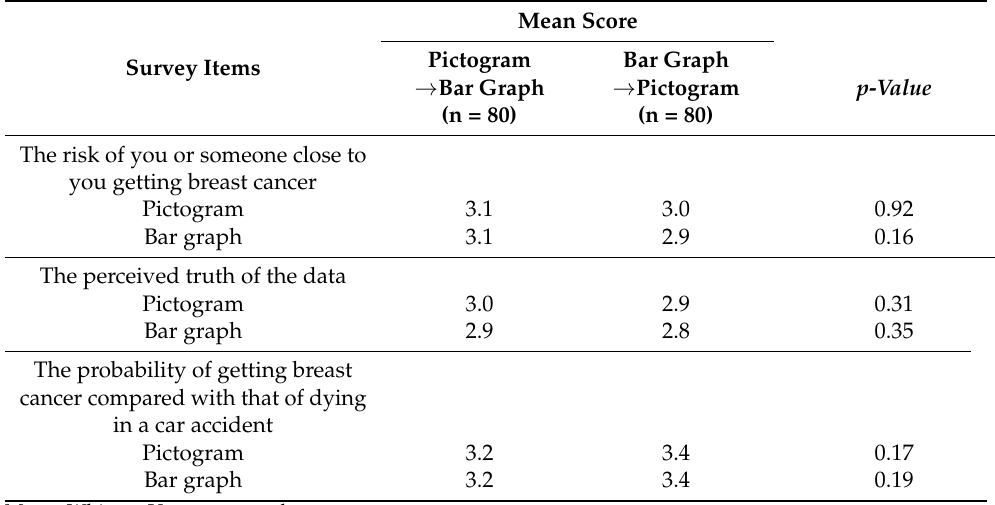
Table 5. Differences in risk perception and data reliability depending on the order in which data presentation styles were